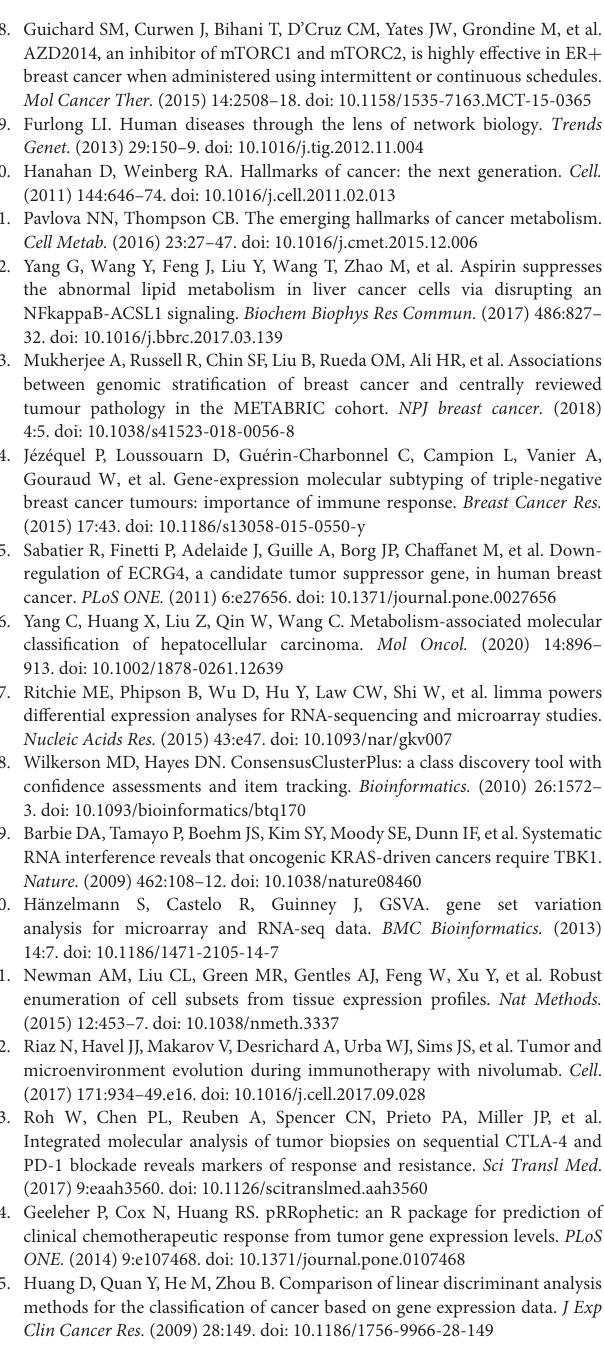
Supplementary Figure 6 | Kaplan-Meier survival curves of five subtypes of breast cancer including basal (A) , her2 (B) , luminal A (C) , luminal B (D) , and normal (E) grouping by high and low expression groups of the seven key genes. Supplementary Table 1 | The 42 co-significant genes between RNASeq and GSE cohorts were collected. Supplementary Table 2 | The enriched pathways of interacted